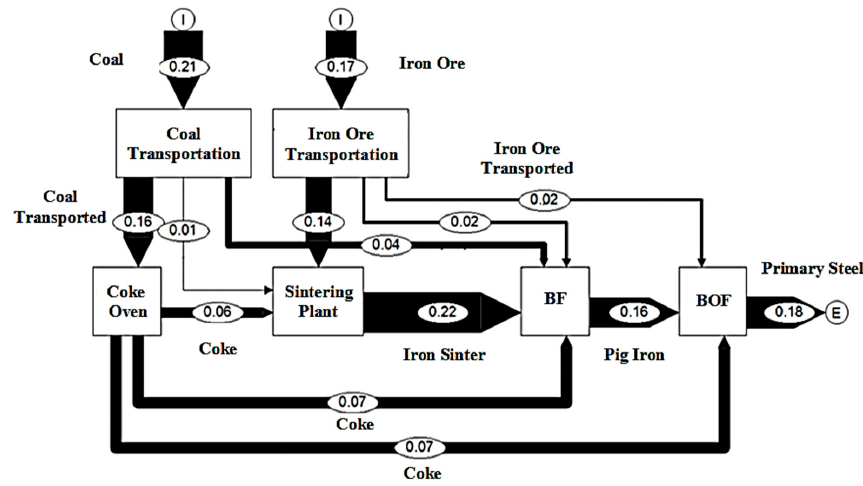
Figure 3. Integrated primary steelmaking process system used for avoided impact calculation.